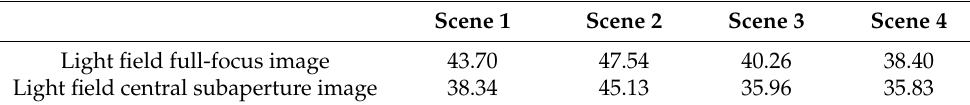
Table 1. Image clarity evaluation Tenengrad value (Retain two decimal places).